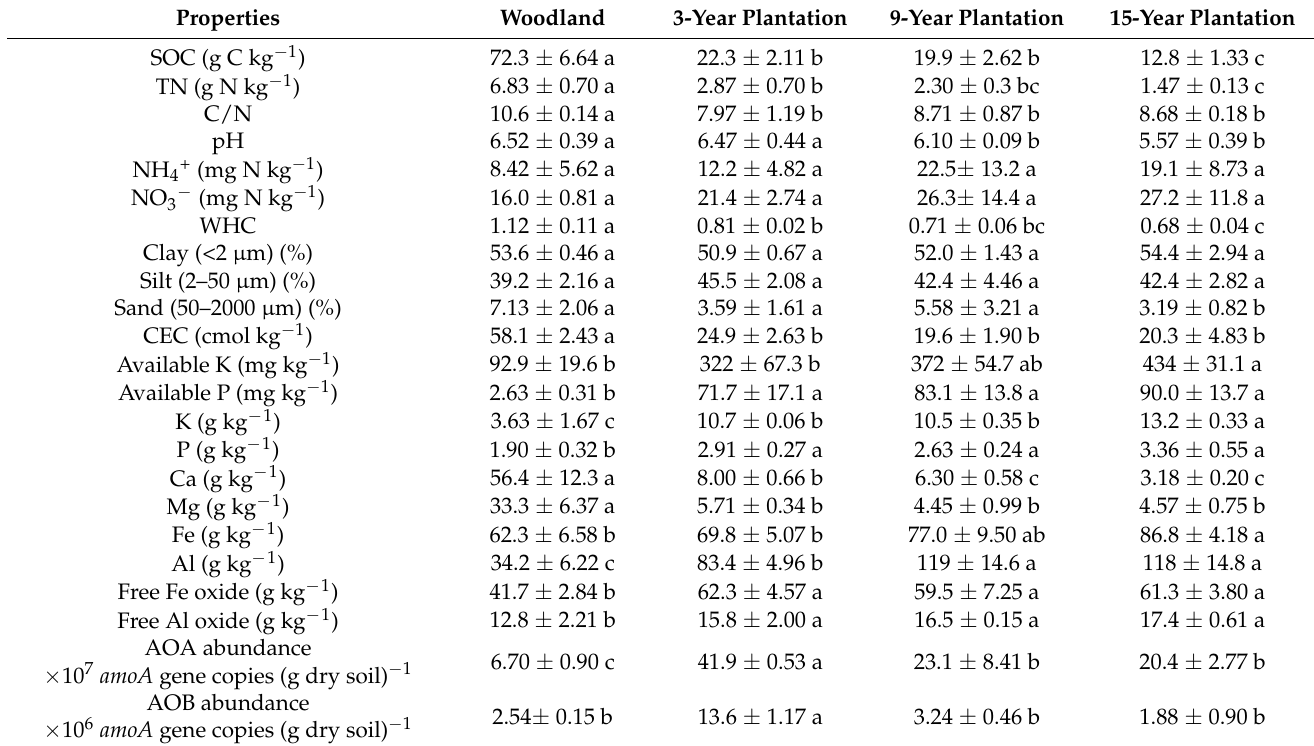
Table 1. Soil properties under woodland and three pitaya plantations ( n =